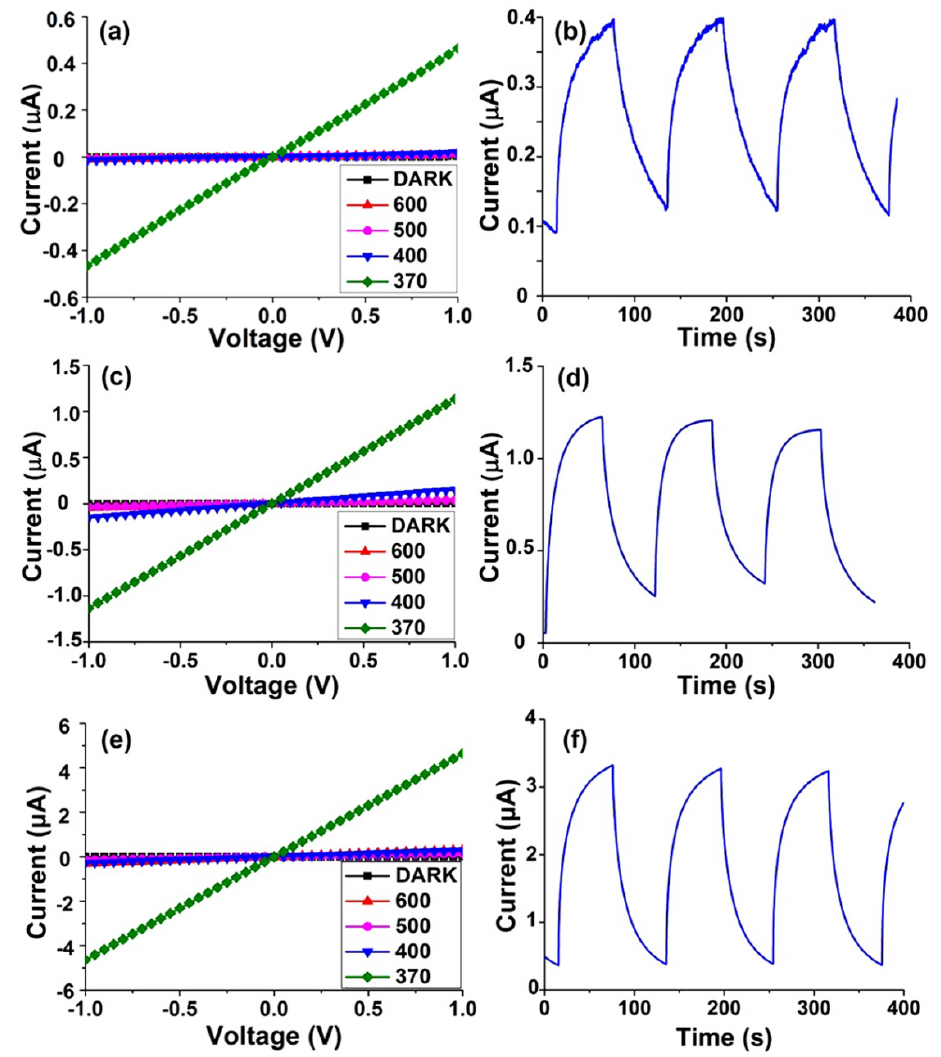
Figure 7. The current–voltage (I–V) curves and time ‐ dependent response (at 370 nm, 1 V bias) of film devices with different CA/ZA molar ratios: ( a , b ) 0:1; ( c , d ) 0.2:1; ( e , f ) 1:1.